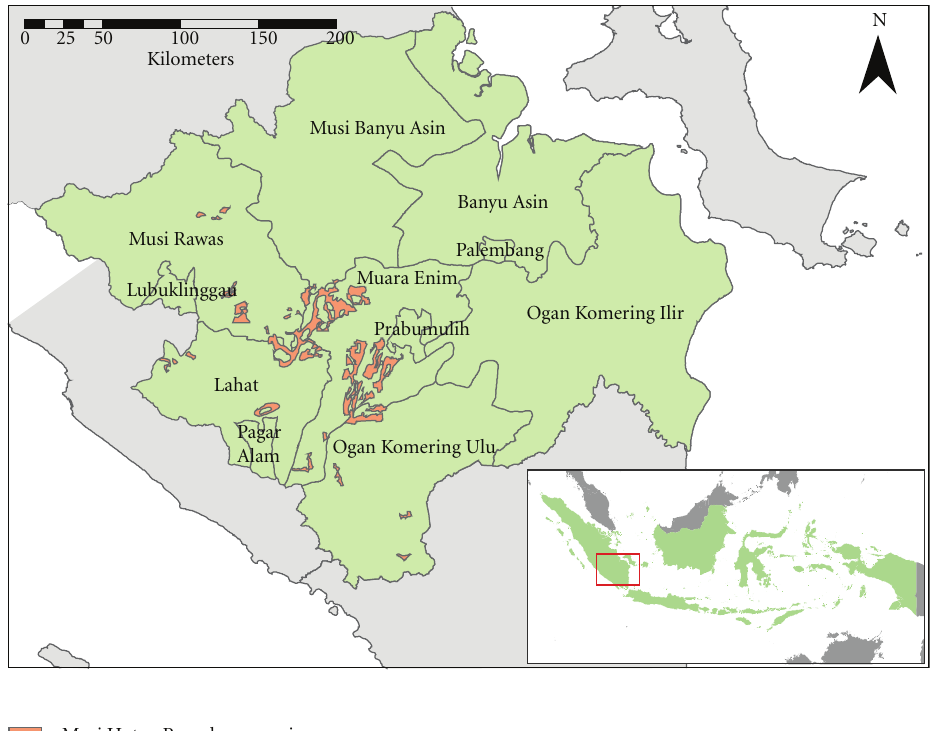
Figure 1: MHP’s forest plantation concession in South Sumatra Province (inset Indonesia).